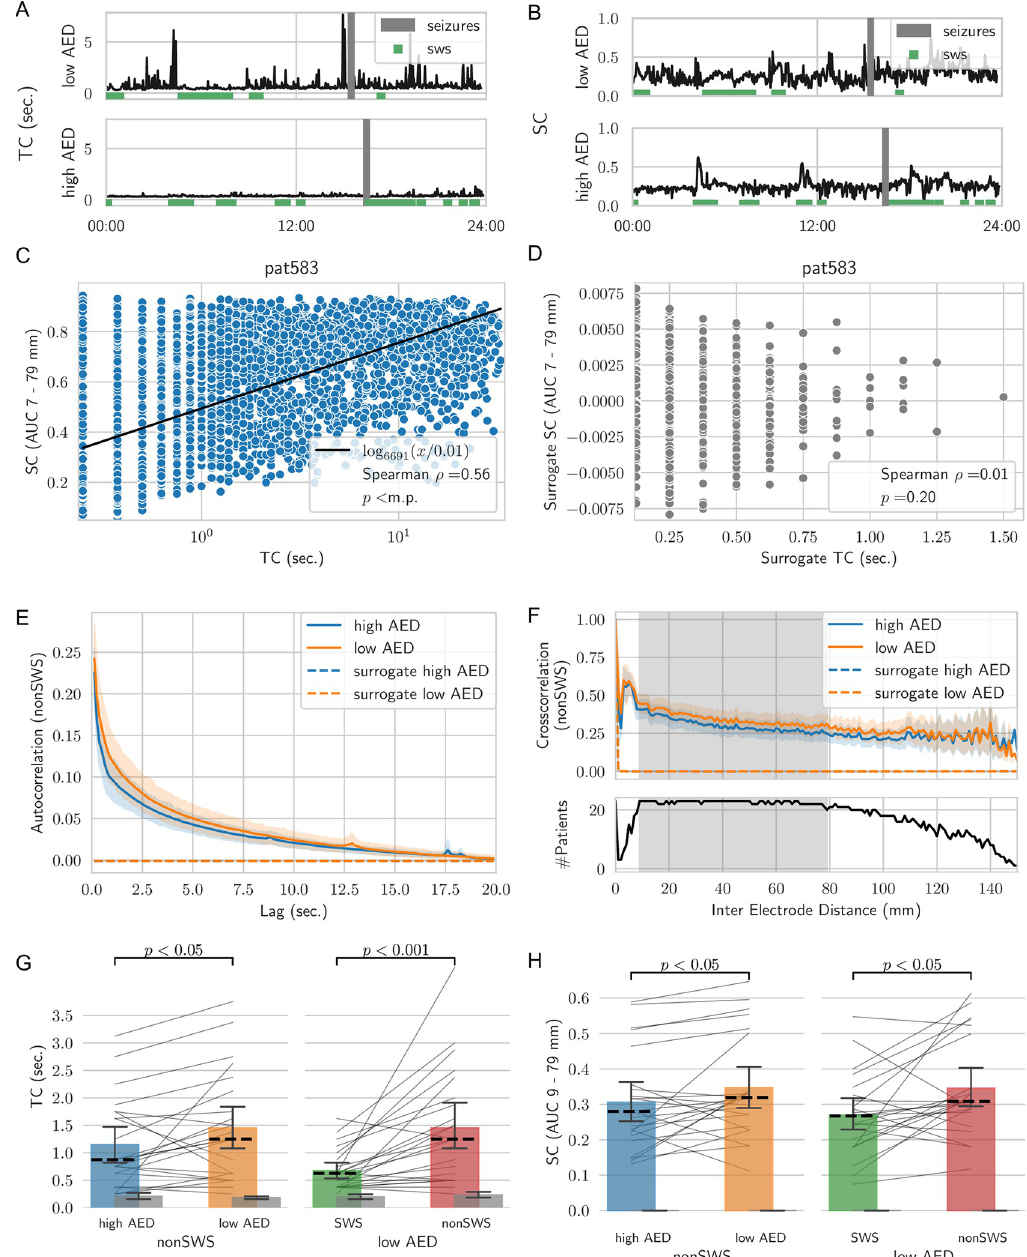
Fig 2. Spatial and temporal correlations (SC, TC) are tightly linked, decline under AED action and break down during slow-wave sleep (SWS). A, B Timeseries of TC and SC over one day for high and low AED dosages for one exemplary patient. SWS is marked with green squares and seizures (grey bars) are excluded from the analysis. C Co-variation of SC and TC shown for one patient. The black line indicates a logarithmic fit. D Surrogate data of SC and TC are overall smaller and exhibit no co- dependence. E, F Autocorrelation and cross-correlation functions averaged over all patients exhibit a faster decline during high AED load days. The grey shaded area in F was used for the SC calculation. G , H Reduction of TC and SC during SWS and high AED load (Wilcoxon signed rank test). Single patient values are indicated as thin lines, the median is given as dashed line and whiskers extend to the 95% confidence interval calculated via bootstrapping. Surrogate data (grey bars) exhibit no difference.